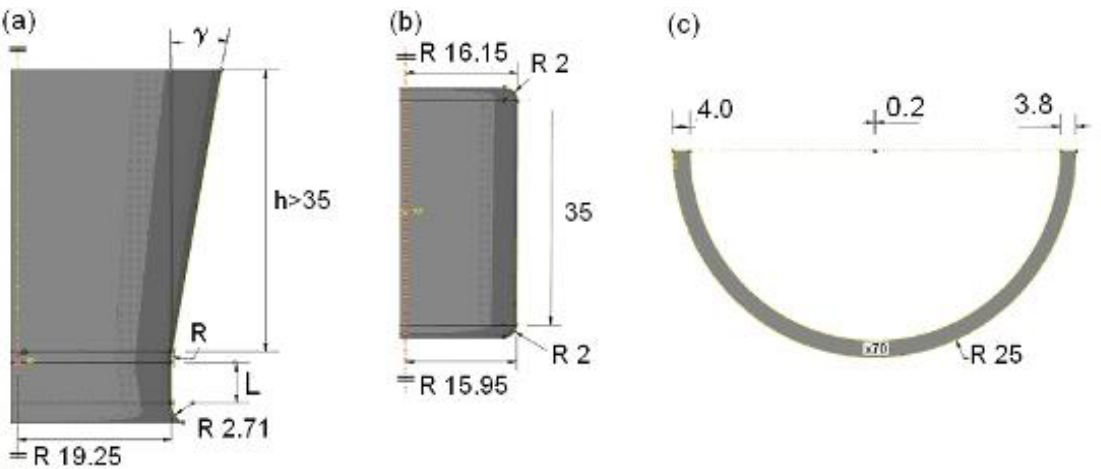
Figure 2. Geometrical model with example data: ( a ) die; ( b ) plug; and ( c ) thin-walled tube. All units are in